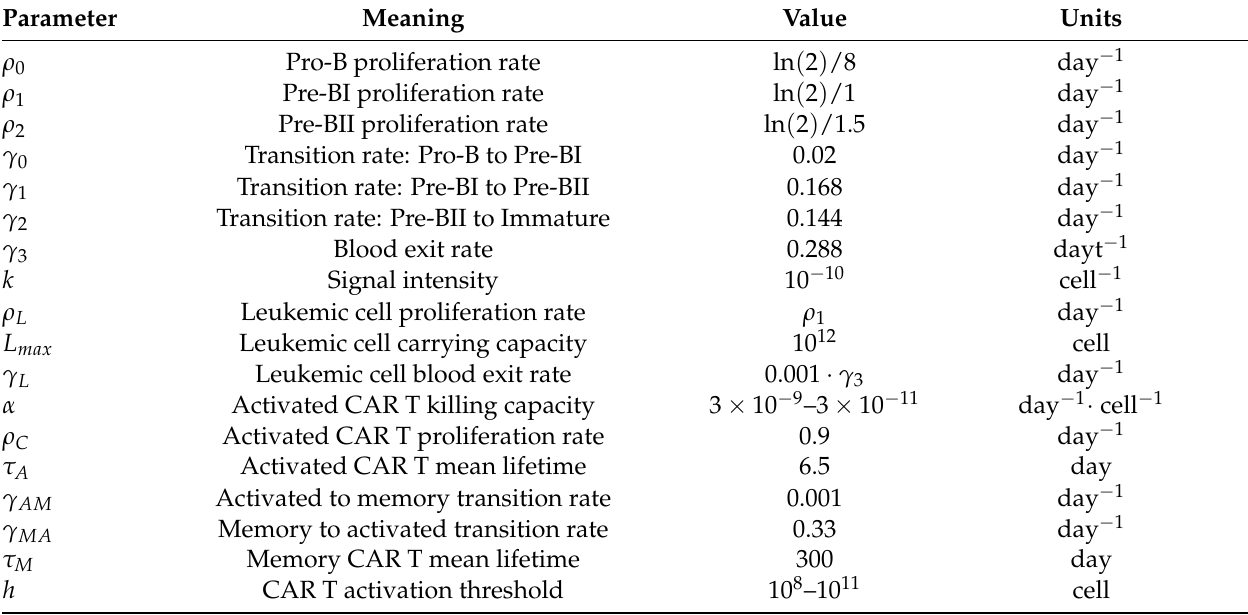
Table 1. Parameter values for the biomathematical model given by Equations